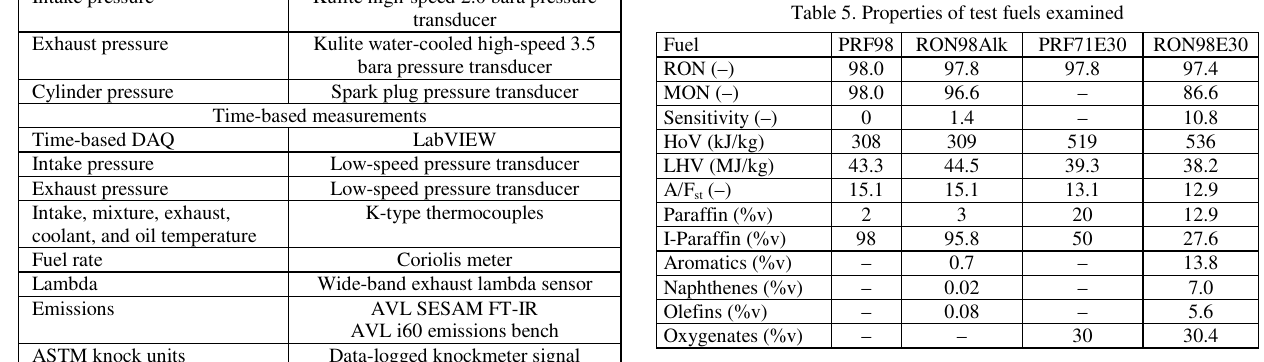
Table 4. Modern engine combustion research measurement and instrumen- tation upgrades to the Argonne CFR F1/F2 engine Crankshaft angle-based measurements Crank-angle based DAQ